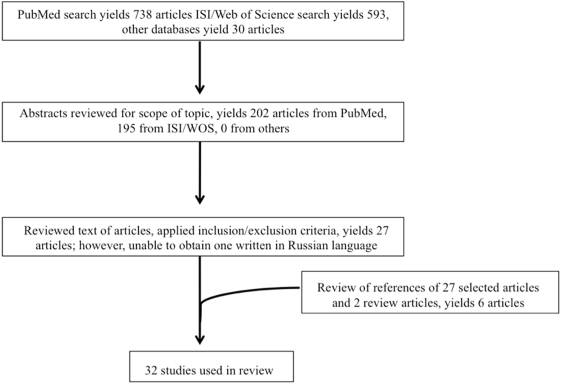
Search strategy.